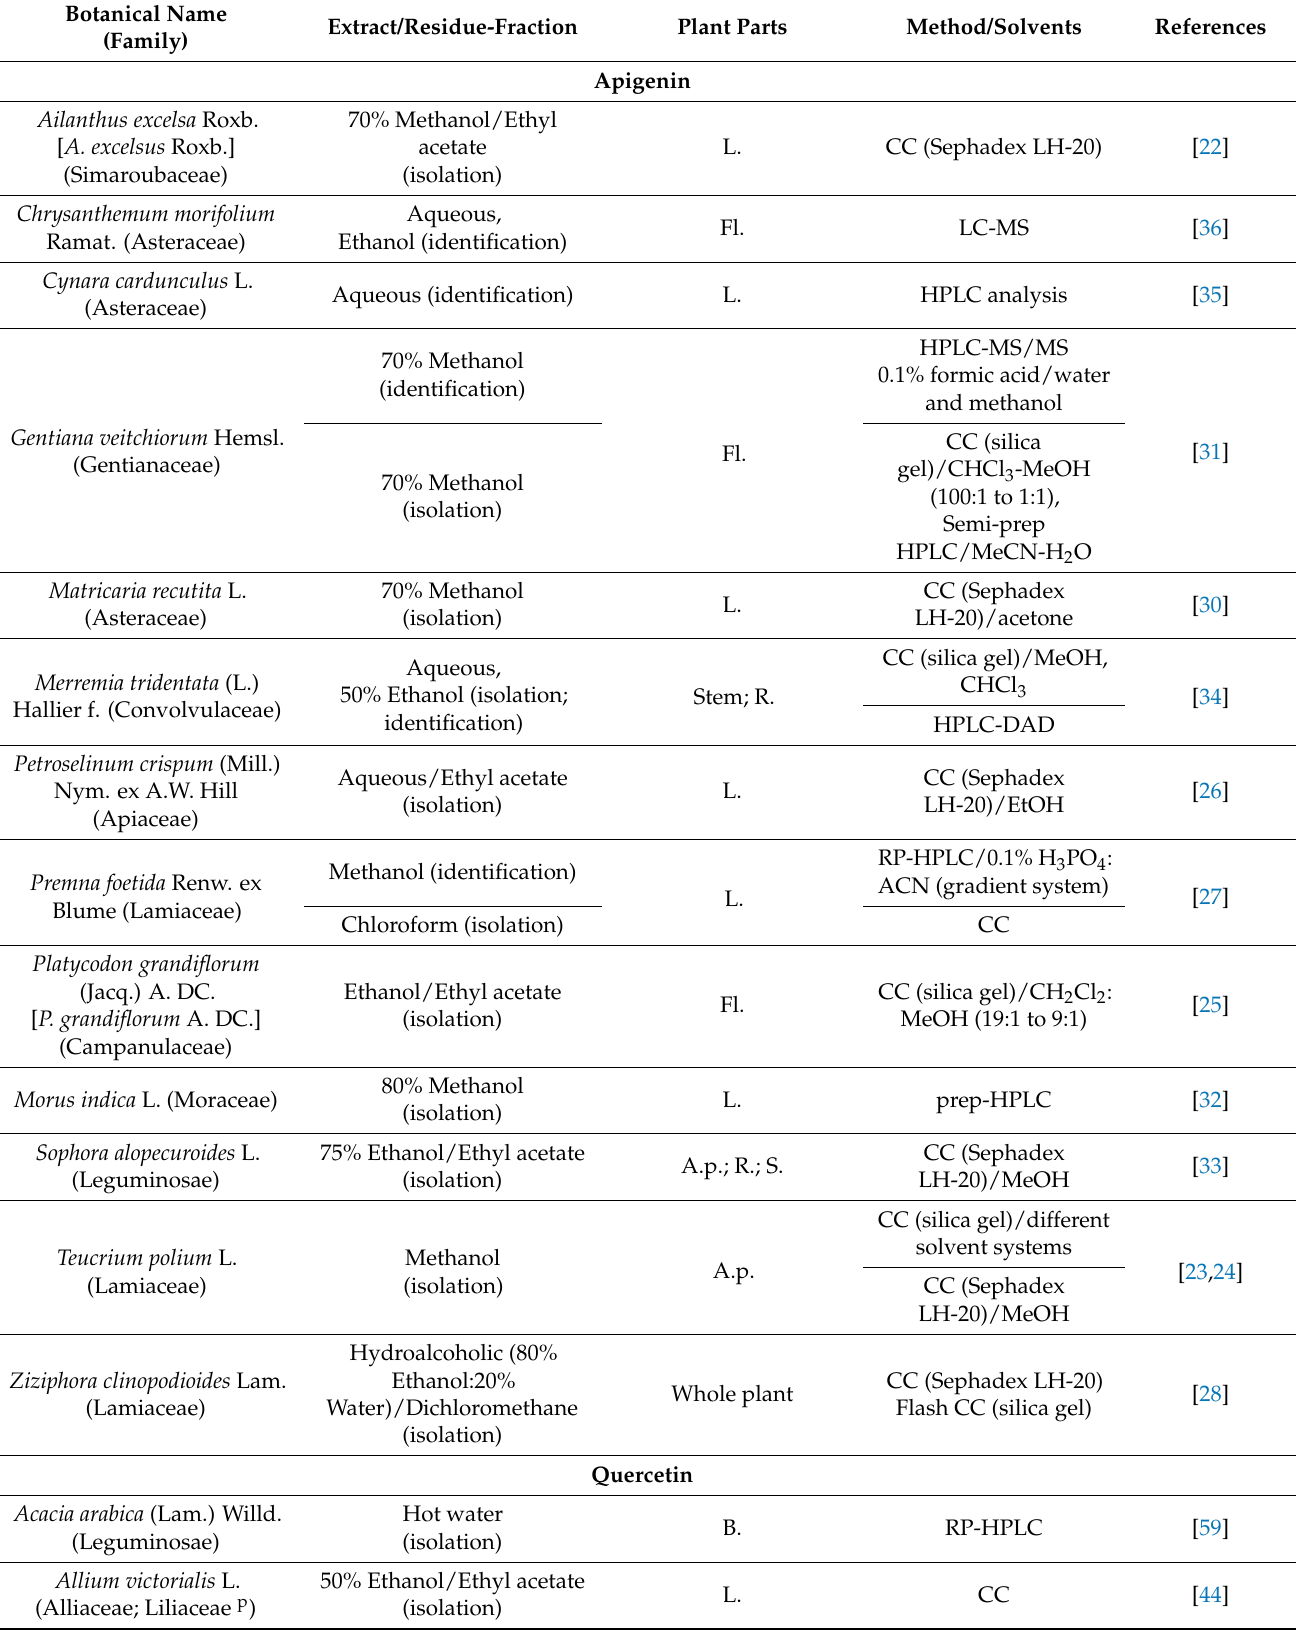
Table 1. Methods of isolation and identification of apigenin, quercetin, and silibinin from